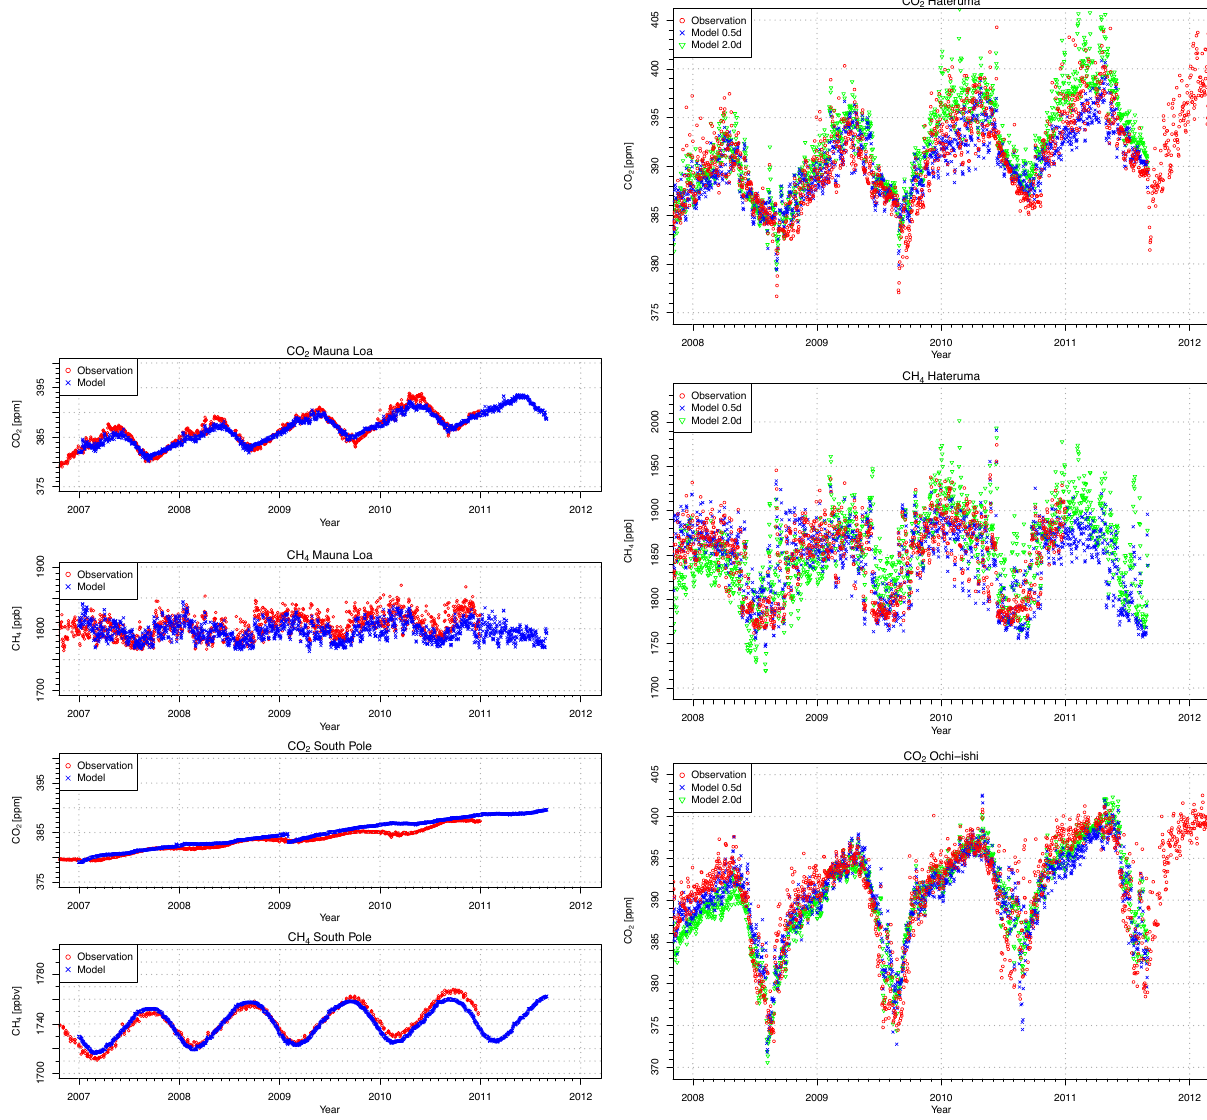
Fig. 6. Observed and simulated time series of daily mean CO 2 and CH 4 concentrations at Mauna Loa, South Pole and Hateruma sites, and CO 2 concentration at Ochi-ishi sites. CH 4 observations at South Pole are discrete data and are plotted directly; quasi-continuous data at the other sites and 3-hourly model output are daily averages. “0.5d” and “2.0d” in legends for Hateruma and Ochi-ishi sites indicate 0.5-degree simulation and 2.0-degree simulation, respectively. A gap in the simulated CO 2 at SPO at the end of January 2009 is due to the offset correction (see